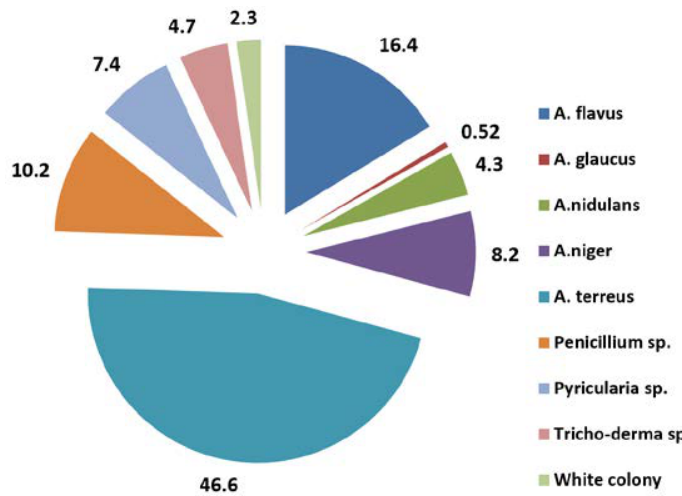
Fig. 3. Percentage distribution of fungi in soil samples of Leather industry Environment